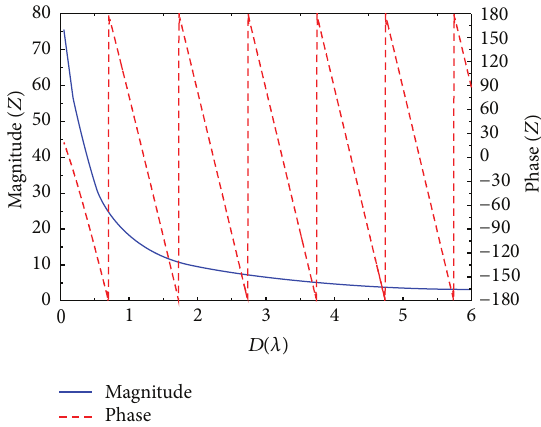
Figure 2: Variation of mutual impedance between two half- wavelength, center-fed dipoles with interelement